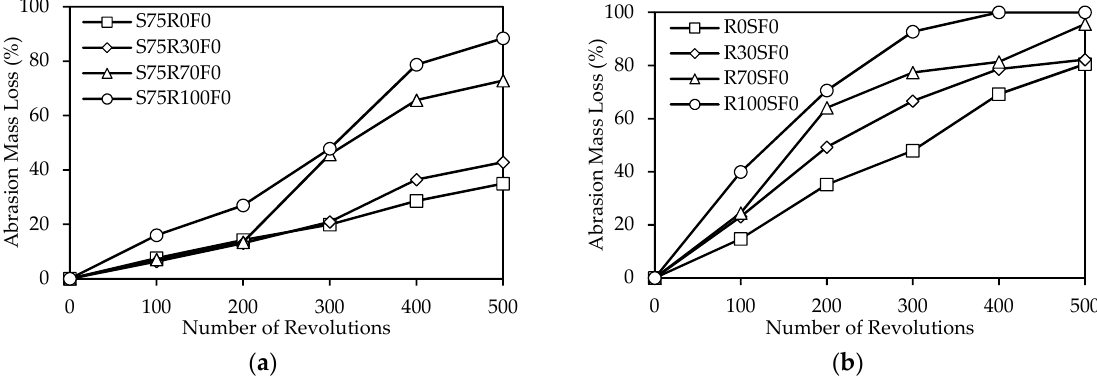
Figure 21. Typical abrasion resistance development profile of alkali-activated concrete with slag:fly ash ratio of: ( a ) 3:1; ( b ) 1:1.